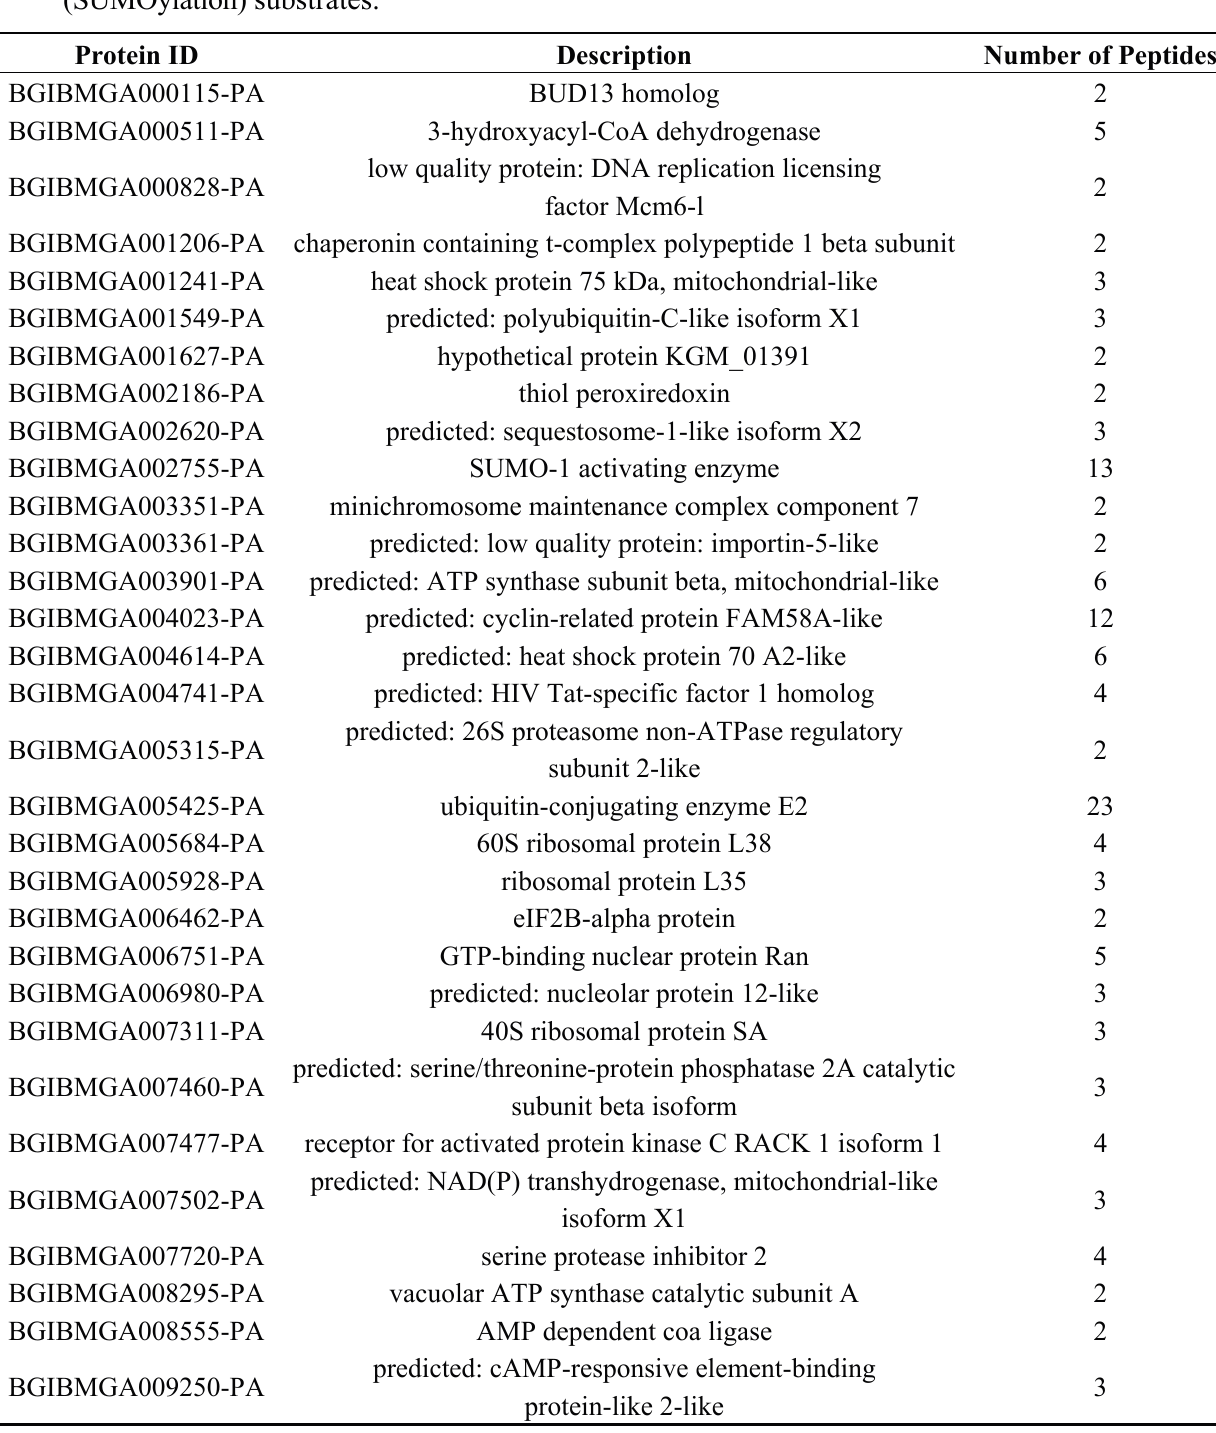
Table 1. Proteins identified as small ubiquitin-like modifier (SUMO) modification (SUMOylation)